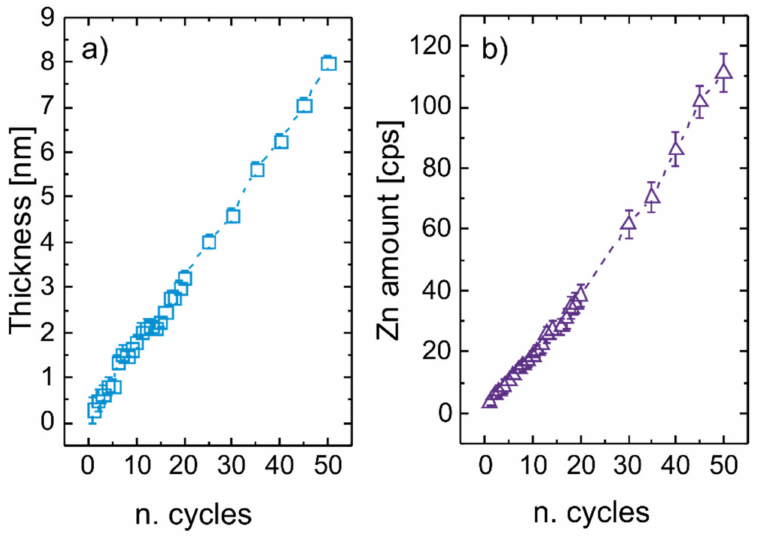
Figure 4. ( a ) Thickness vs. number of cycles as derived from SE; ( b ) Zn amount in cps from the XRF